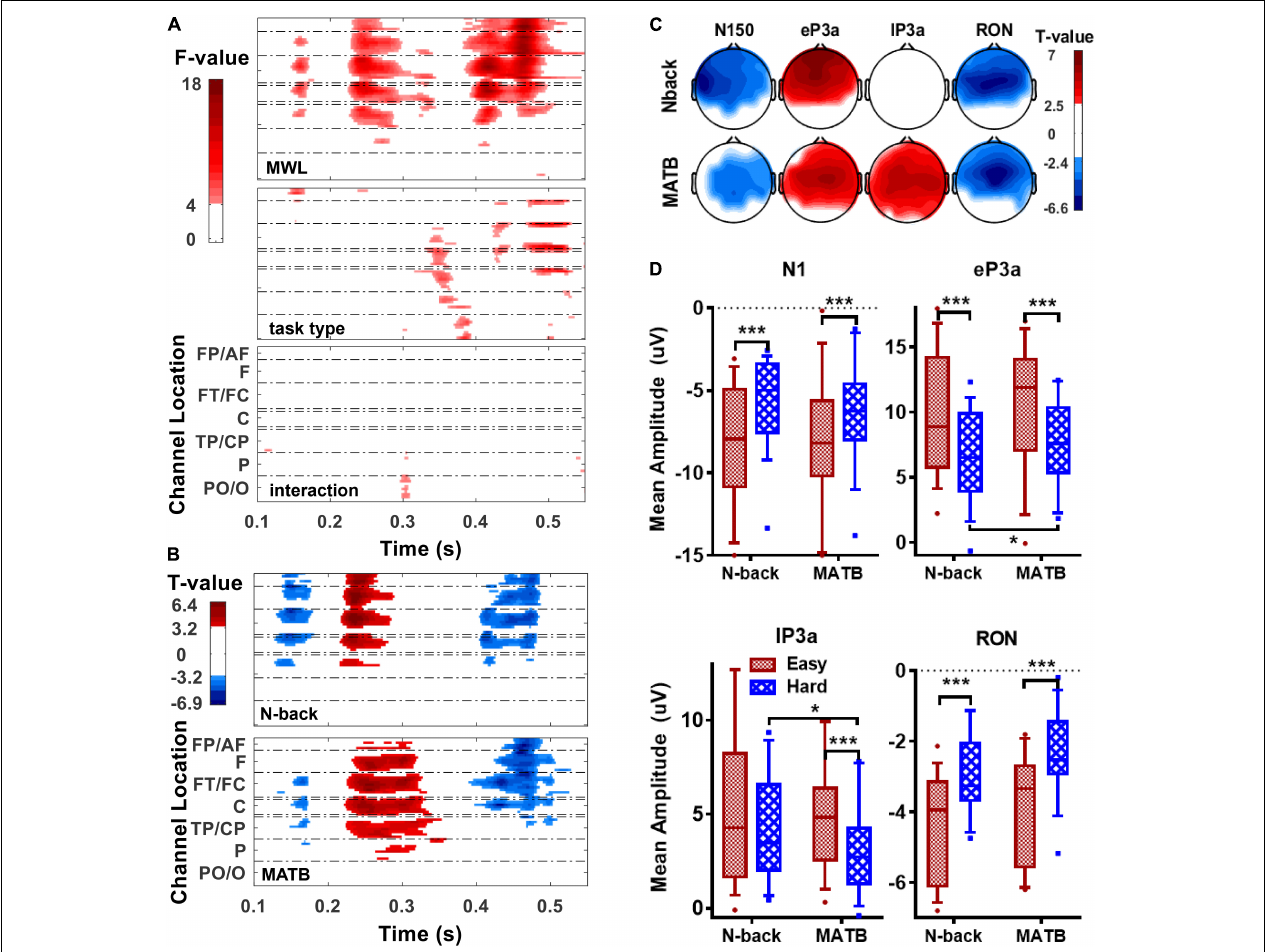
FIGURE 3 | Statistical results for the tir-aERPs. (A) The spatial–temporal maps of F -values obtained from two-way (MWL × task type) repeated-measure ANOVAs on event-related potentials (ERPs) at each channel and each sample. (B) The spatial–temporal maps of T -values obtained from paired t -tests (easy–hard) on ERPs at each channel and each sample for N-back (upper panel) and multi-attribute task battery (bottom panel). (C) The topological maps of T -values obtained from paired t -tests (easy–hard) on the four ERP components at each channel in N-back (upper panel) and MATB (bottom panel). (D) The box plots of the amplitudes and the statistical significance of ERP components at channel Fz. The asterisks in the figure indicate the significance level of the statistical analyses: * p FDR < 0.05; *** p FDR < 0.001. The statistics of no significance ( p FDR > 0.05) were set to 0 in (A–C) . AF, anteriofrontal; FP, pre-frontal; F, frontal; FT, frontotemporal; FC, frontocentral; C, central; CP, centroparietal; TP, temporoparietal; PO, parietooccipital; O,